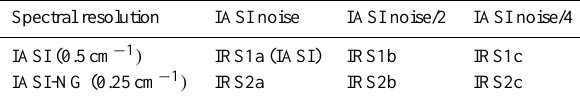
Table 1. The six infrared sounder (IRS) scenarios.